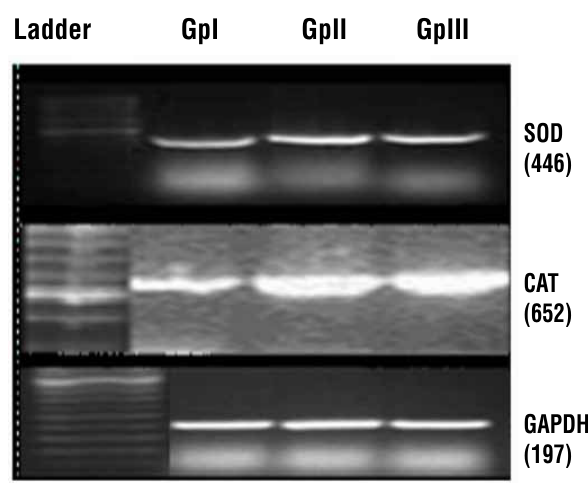
Table 3 - Effect of coconut water on Lipid peroxidation status in the kidney.